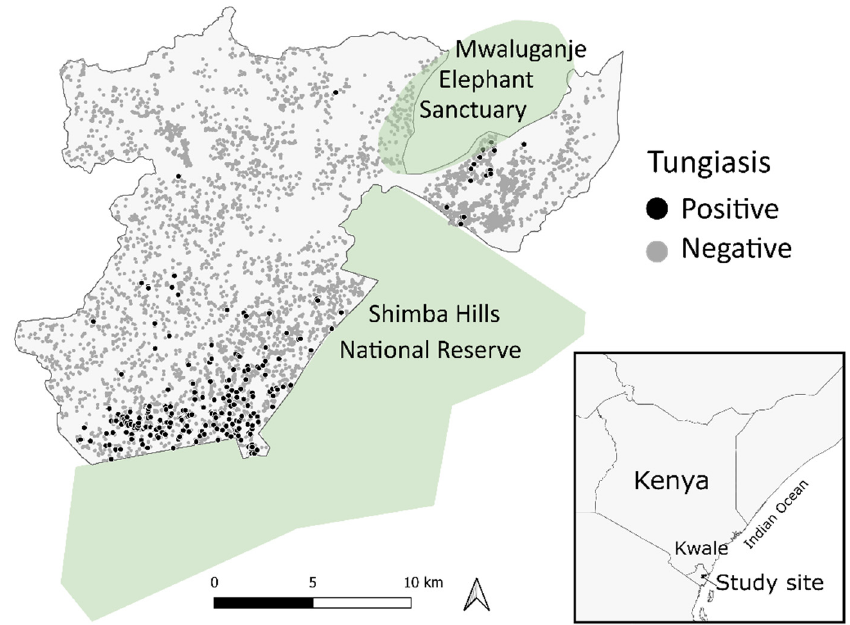
Figure 1. Distribution of the households with or without tungiasis in the Kwale-HDSS area.